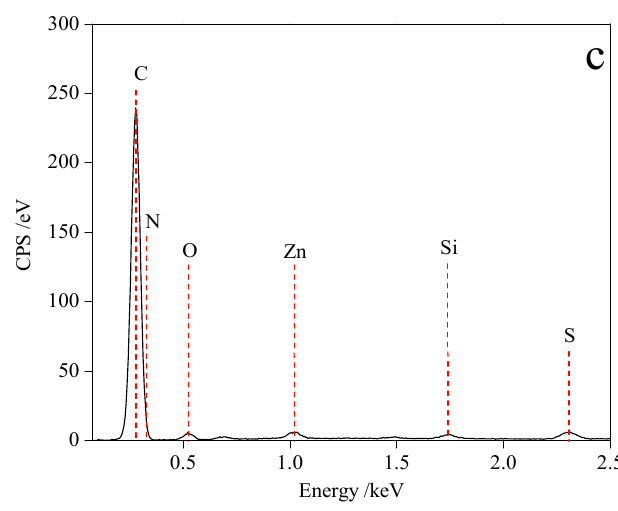
Figure 13. The energy dispersive spectroscopy (EDS) analyses of ( a ) WRP, ( b ) 1-ODA-WRP, and ( c ) 3-ODA-WRP.